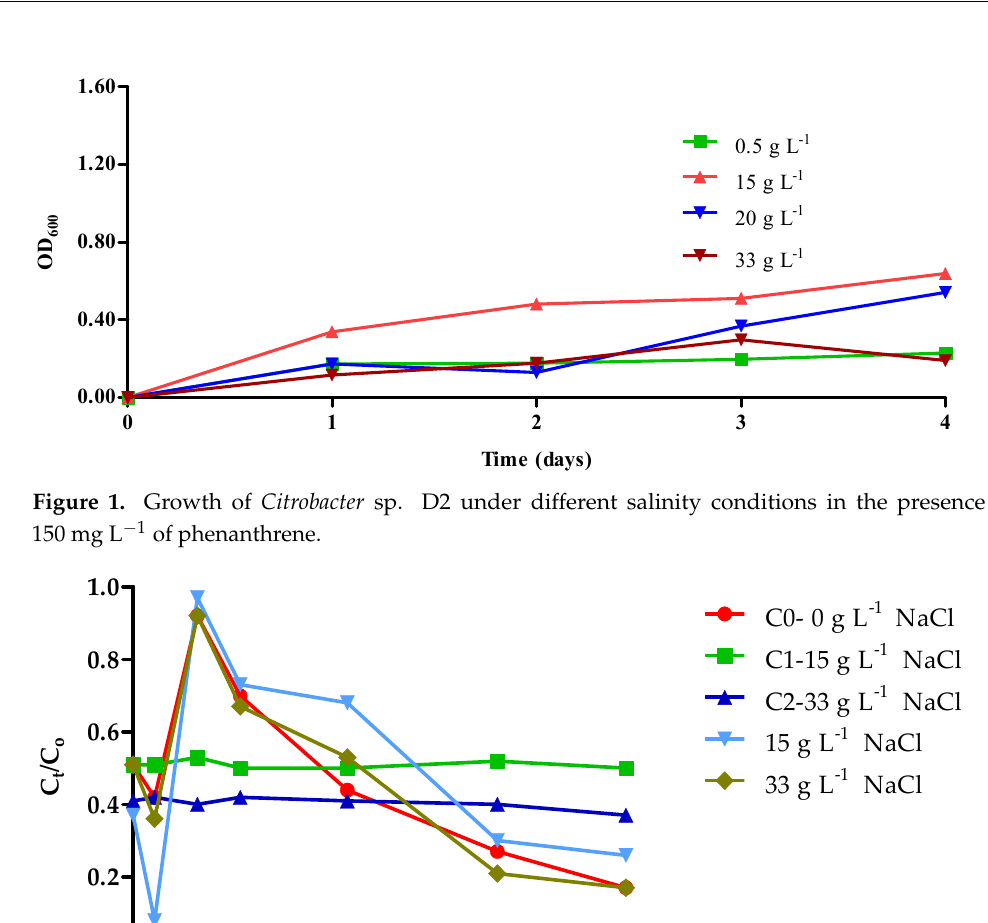
Figure 1. Growth of Citrobacter sp. D2 under different salinity conditions in the presence of 150 mg L − 1 of phenanthrene.